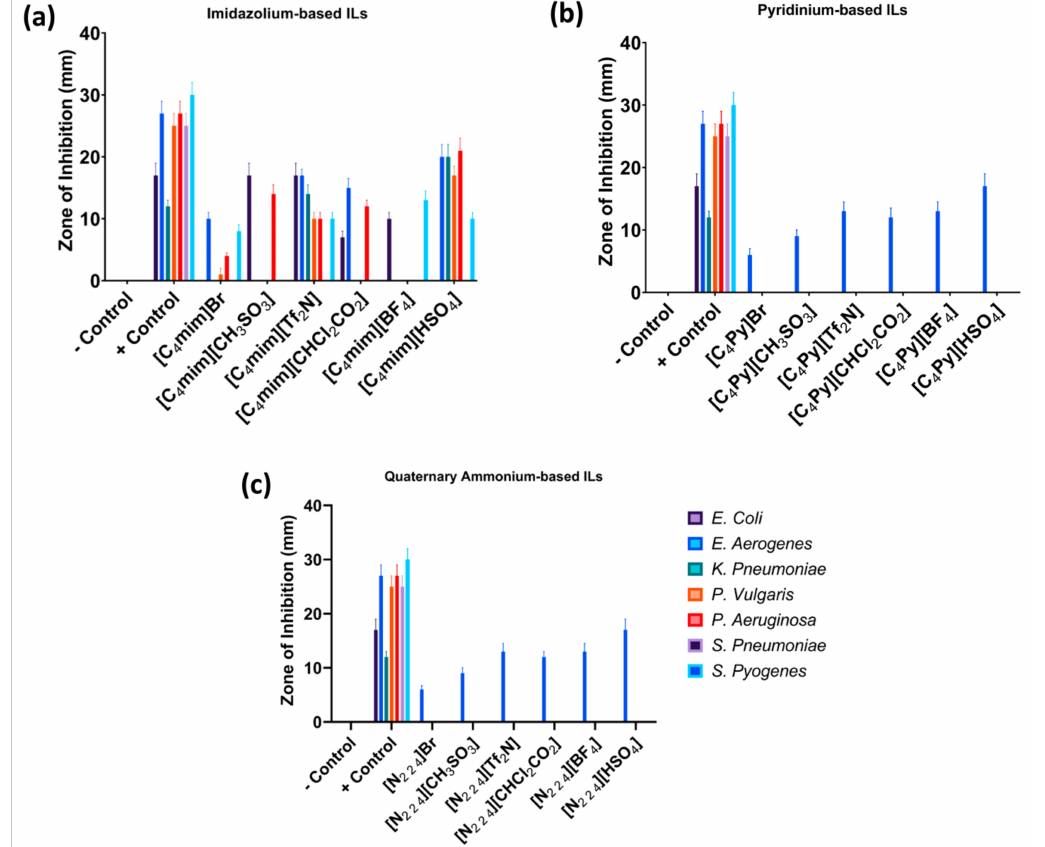
Figure 1. Antibacterial activity of ILs against five Gram-negative bacteria and two Gram-positive bacteria ( Escherichia coli ; Enterobacter aerogenes ; Klebsiella pneumoniae ; Proteus vulgaris ; Pseudomonas aeruginosa ; Streptococcus pneumoniae ; Streptococcus pyogenes ): ( a ) imidazolium-based ILs show good antibacterial activity against most of the tested pathogenic bacteria; ( b ) pyridinium-based ILs show antibacterial activity against Enterobacter aerogenes; ( c ) quaternary ammonium-based ILs were antibacterial against Proteus vulgaris and Klebsiella